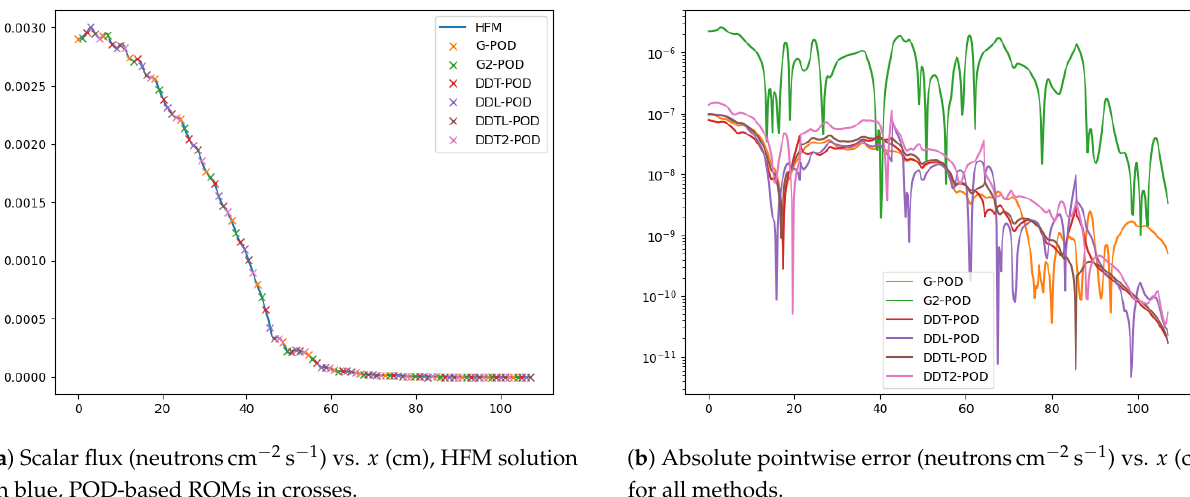
( a ) Scalar flux (neutronscm − 2 s − 1 ) vs. x (cm), HFM solution in blue, POD-based ROMs in crosses. for all methods. Figure 5. Scalar flux for Energy Group 5 for the HFM (blue) and POD methods and the pointwise error between them with parameters R 1 = 2, R 2 = 2, R 3 = 1, R 4 = 1, R 5 =